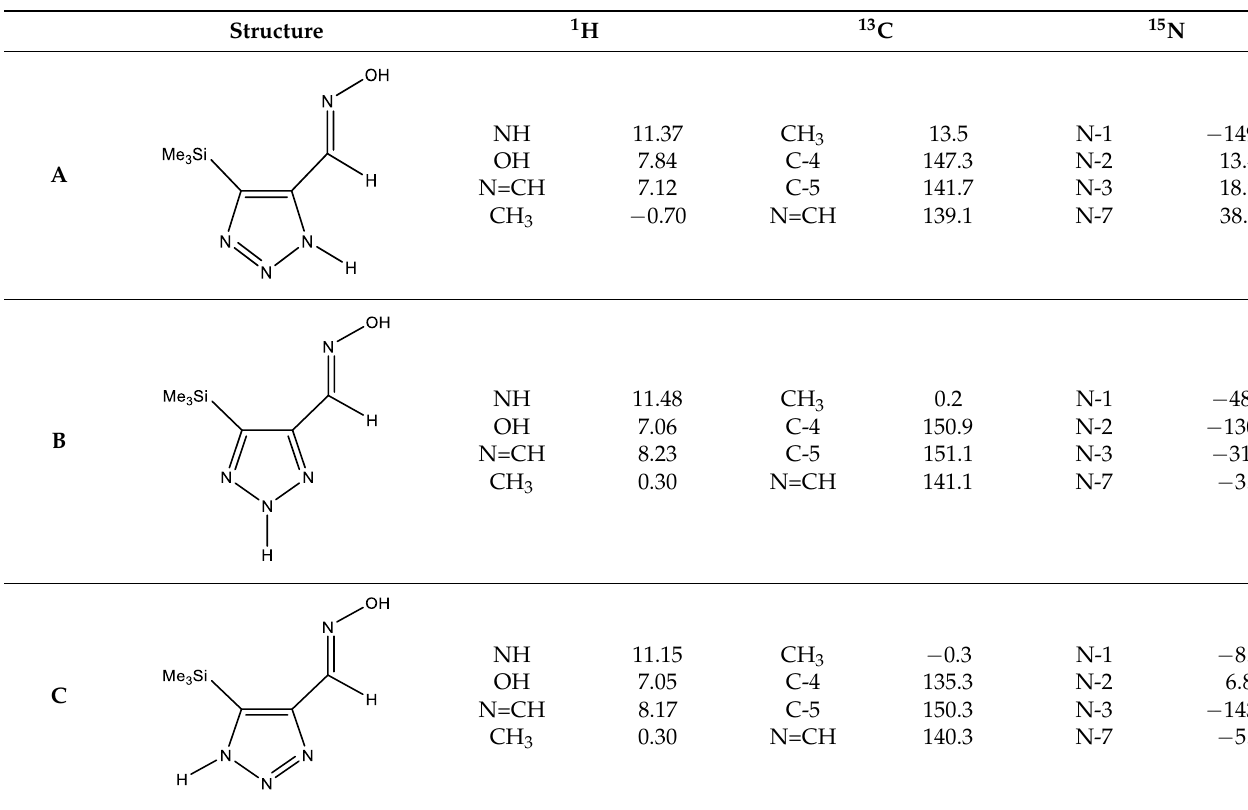
Table 6. Calculated 1 H, 13 C and 15 N NMR chemical shifts of tautomers A , B , and C (ppm) (MP2/aug-cc-pVTZ level).